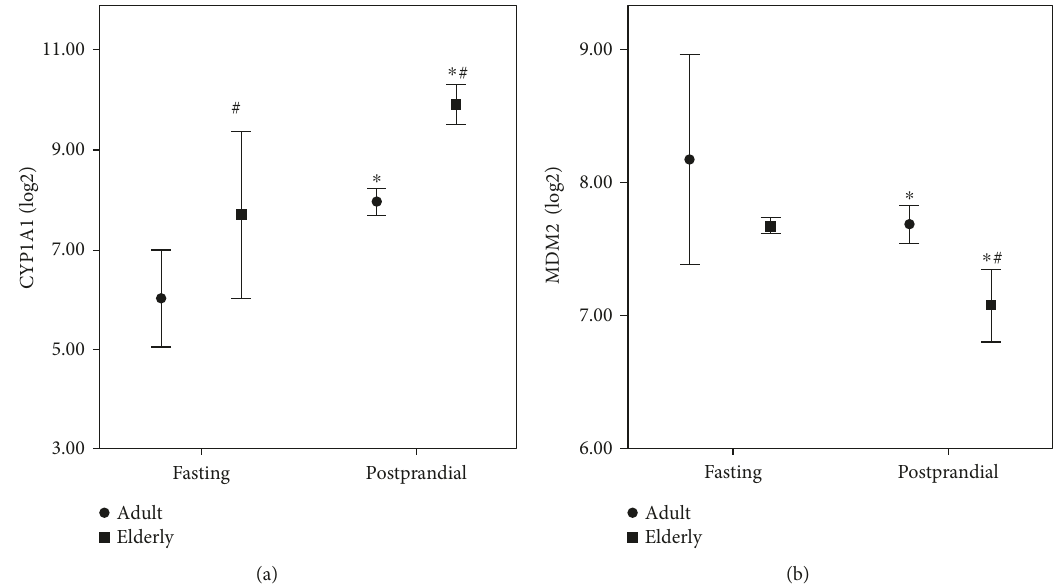
Figure 5: Log2 intensity of CYP1A1 and MDM2 genes in HCAEC exposed to fasting or postprandial serum from adult and elderly donors. ∗ p < 0 01 compared to fasting serum; # p < 0 01 compared to adult